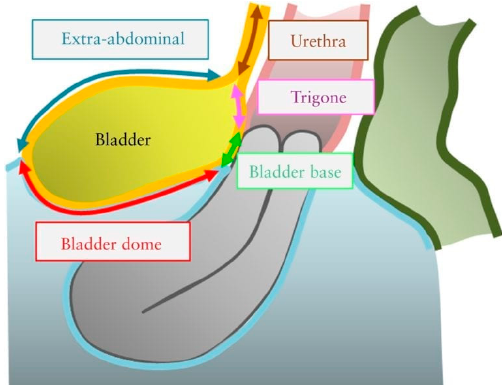
Figure 1. Schematic drawing illustrating the four bladder zones: trigone, bladder base, bladder dome, and extra-abdominal bladder. The demarcation point between the base and the dome of the bladder is the uterovesical pouch. Reprinted with permission from John Wiley and Sons.